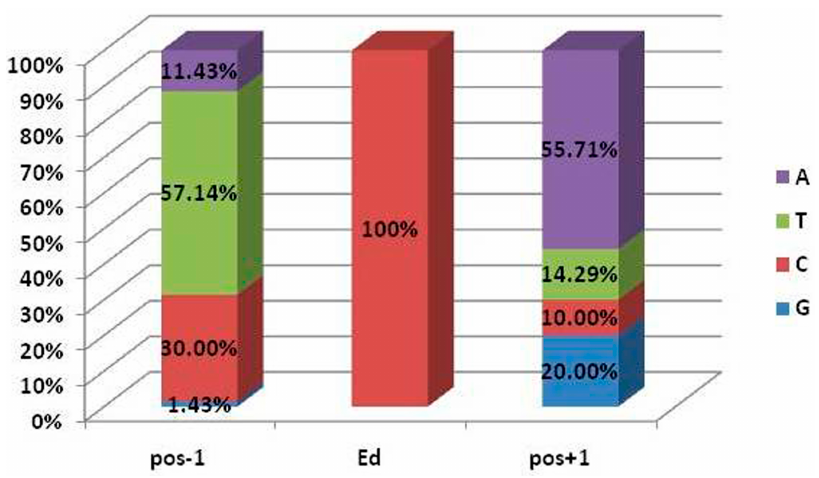
Figure 1. Nucleotide context of editing sites in Ae. tauschii (AL8/78). pos − 1 and pos +1 indicate the direct upstream and downstream nucleotide of the edited sites (Ed).